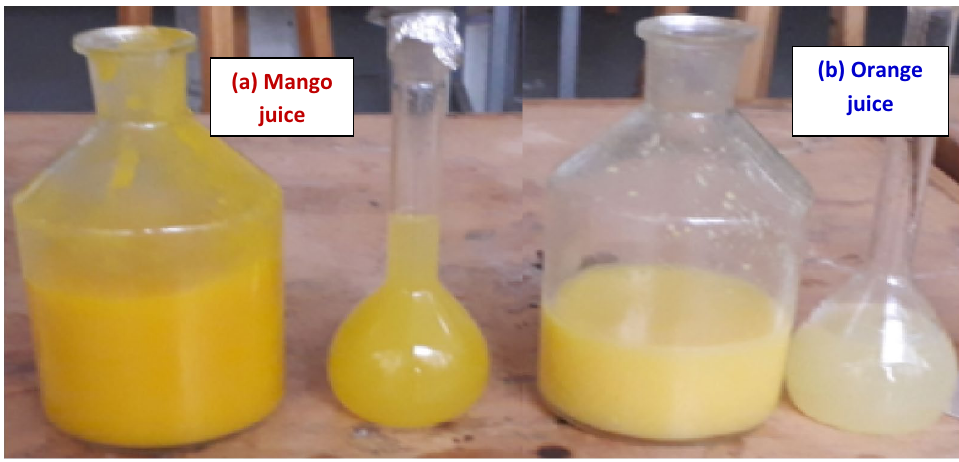
Figure 1. Extracted ( a ) Mango and ( b ) Orange